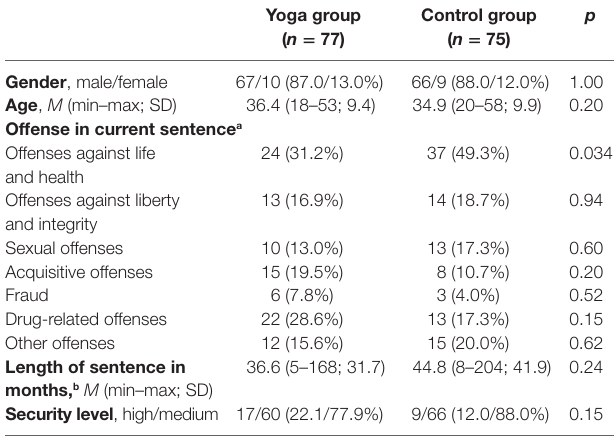
TaBle 2 | Participant characteristics, including comparisons between yoga and control group